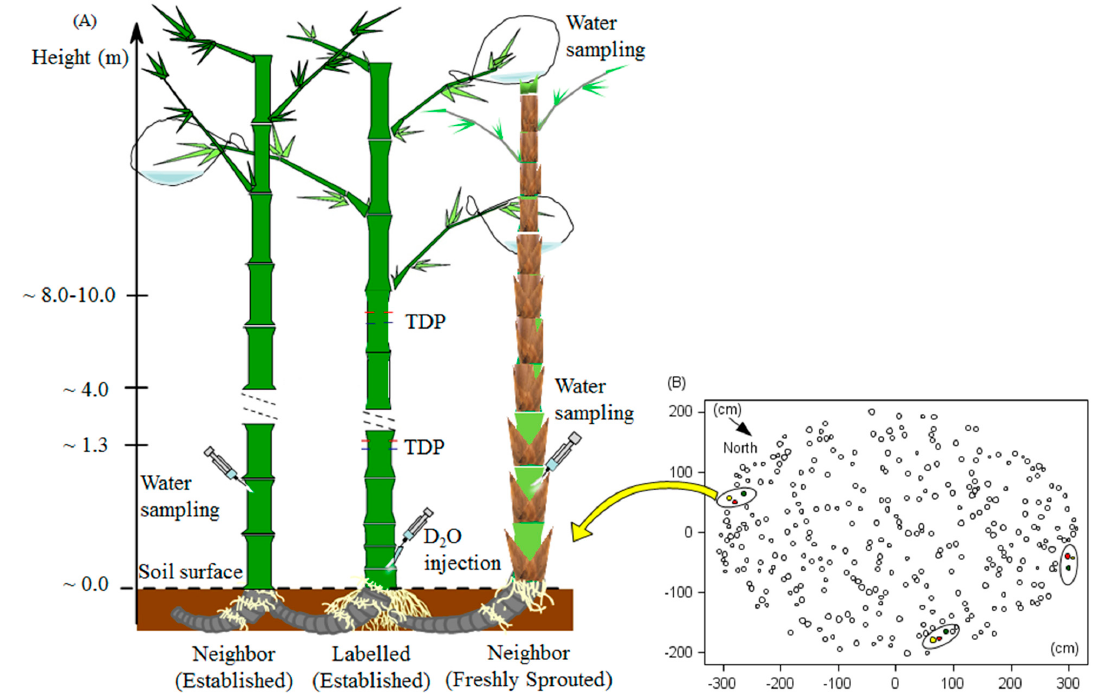
Figure 1. ( A ) Experimental scheme for applying deuterium tracing and thermal dissipation probes (TDP) measurements, ( B ) the locations of labeled culms and their neighbor culms in a clump of B. vulgaris (n = 3 pairs of culms). The red, yellow, and green filled circles represent the labeled-established, the neighbor freshly sprouted, and neighbor-established culms, respectively. The white empty circles represent other, non-studied culms.